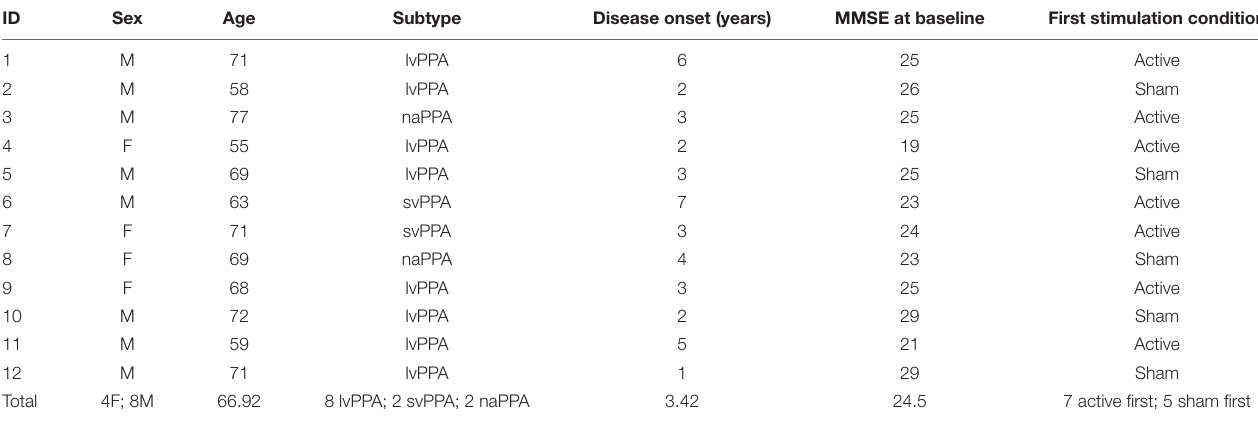
TABLE 1 | Demographics and characteristics of each participant and the total sample (mean age, sex, PPA subtype, years since onset, baseline MMSE score, order of stimulation